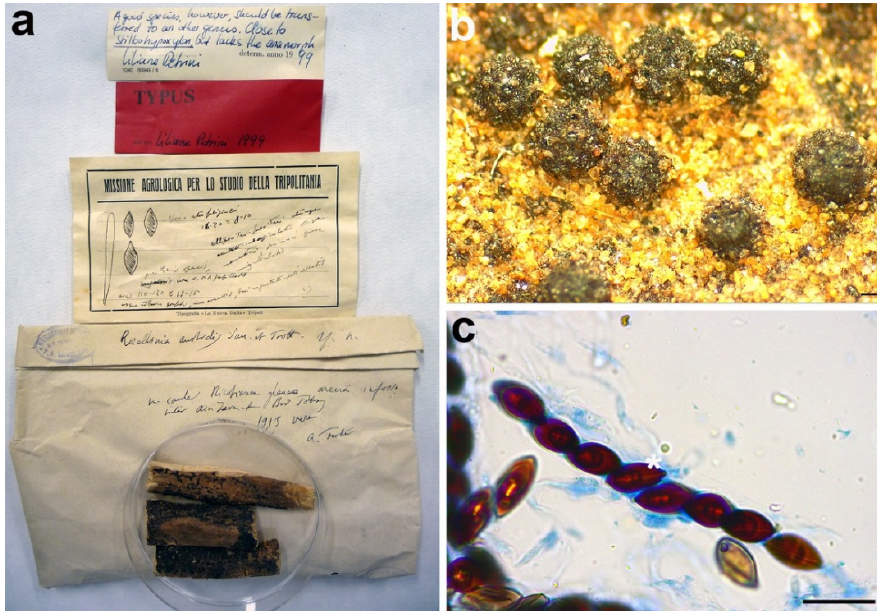
Figure 6. Rosellinia australis . ( a ) Original fungarium specimen. ( b ) Perithecia on natural substrate. ( c ) Ascus with ascospores; ascospore showing germ slit (white asterisk). Scale bars: ( b ) = 200 μ m; ( c ) = 20 μ m.